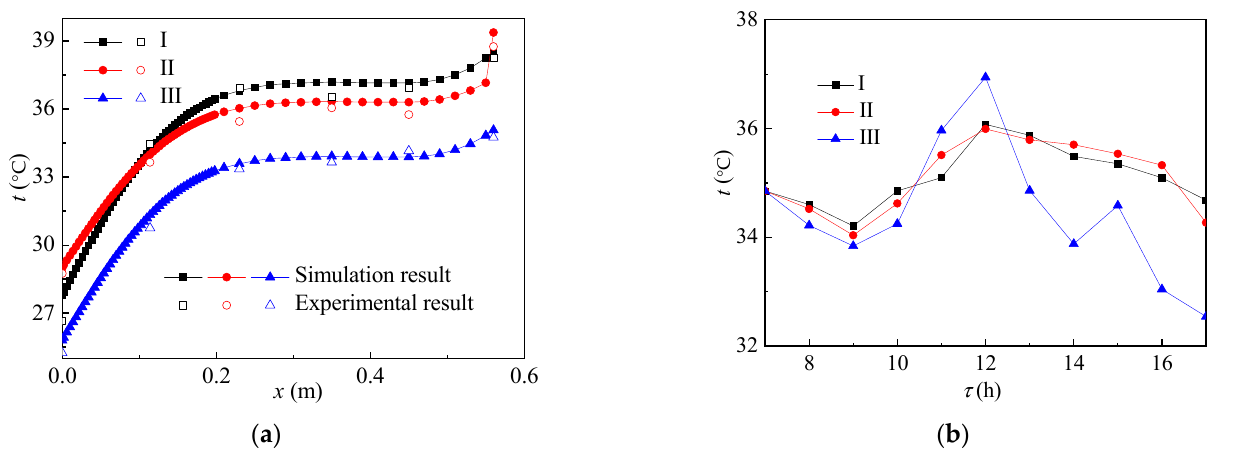
Figure 8. Temperature distribution with the increase in ( a ) height and ( b ) time in the reactor.